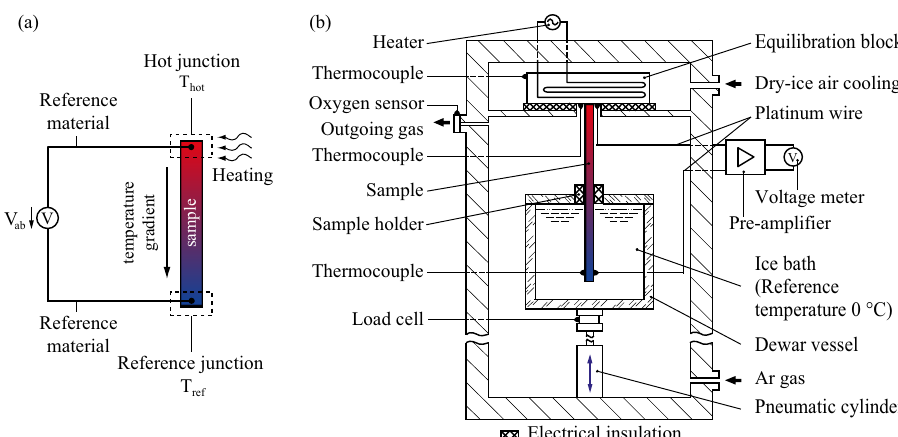
Fig. 1. Schematic diagram of (a) an integral measuring setup for thermocouple calibration and (b) apparatus for measuring relative Seebeck coef fi